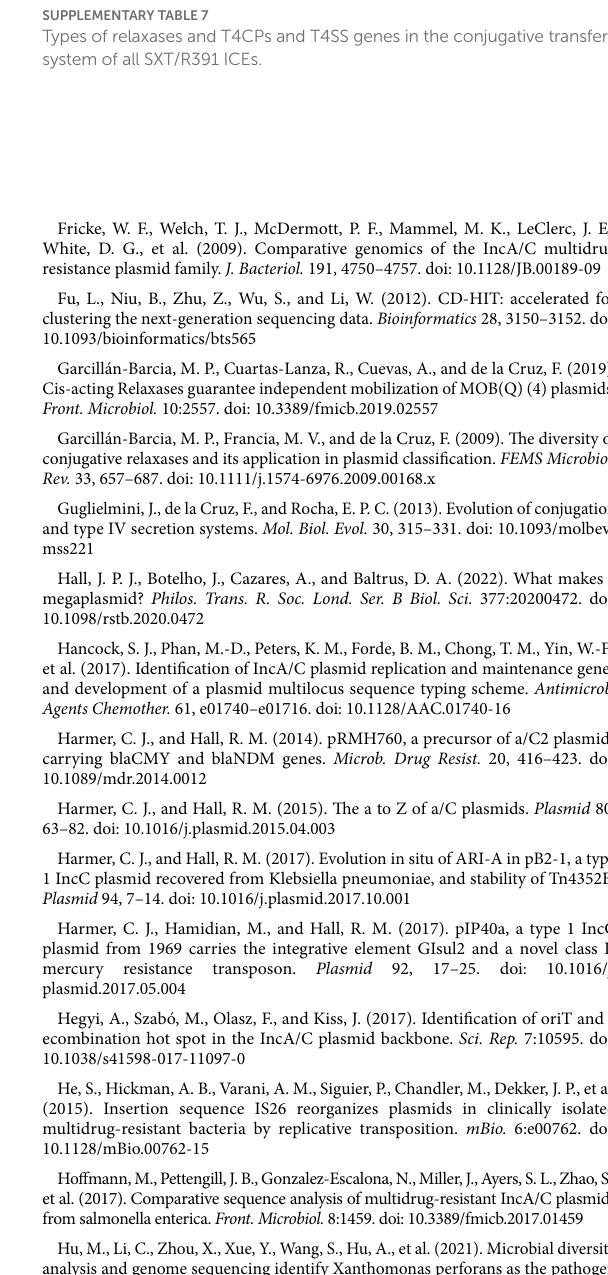
rearrangement in all plasmids and the arrays of backbone genes.